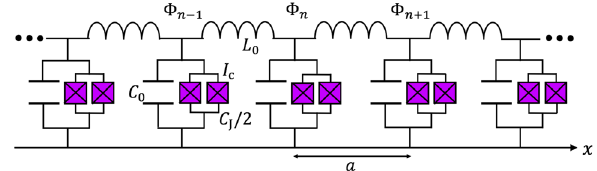
Fig. 1 Circuit diagram for a coplanar waveguide-like transmission line. The inductance for each inductor and the capacitance for each capacitor are assumed to be L 0 and C 0 , respectively. Each SQUID ele- ment consists of two identical tunnel Josephson junctions with critical C J .Thelengthofallthecellsistheconstant current I c andcapacitance 1 2 a . The circuit is characterized by the dynamical fluxes (cid:11)